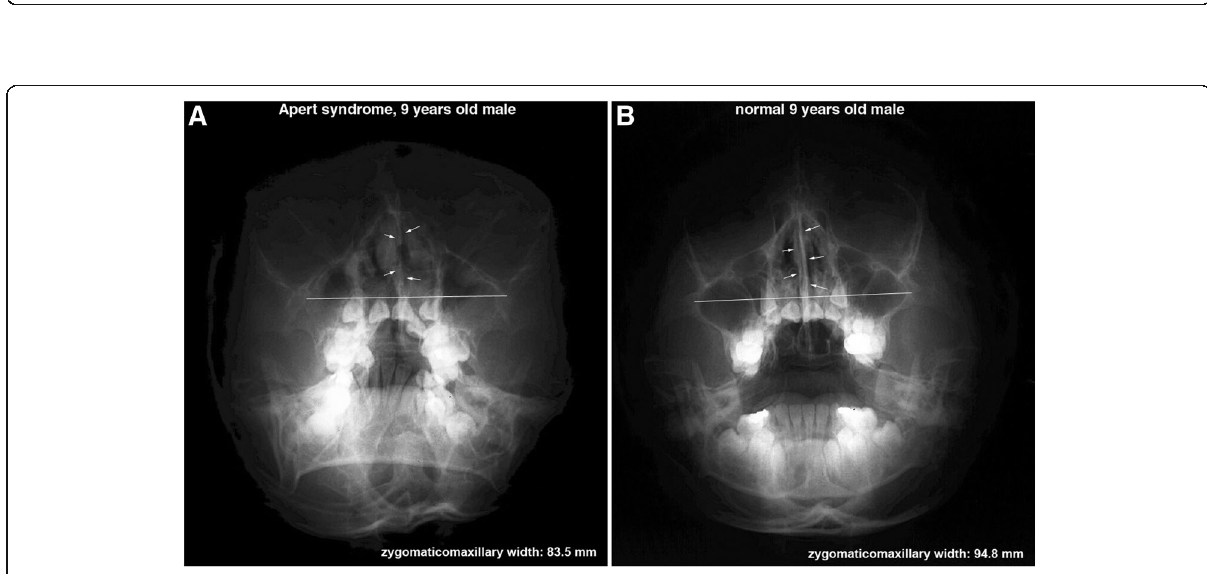
Fig. 2 Panoramic view. a An Apert syndrome patient, a 9-year-old male, with an upward convex palatal plate (arrows) and a short and thin nasal septum (arrow heads). Noted the severe anterior open bite (*). b A 9-year-old normal male with normal horizontal palatal plate (arrows) and a long and thick nasal septum (arrow heads)